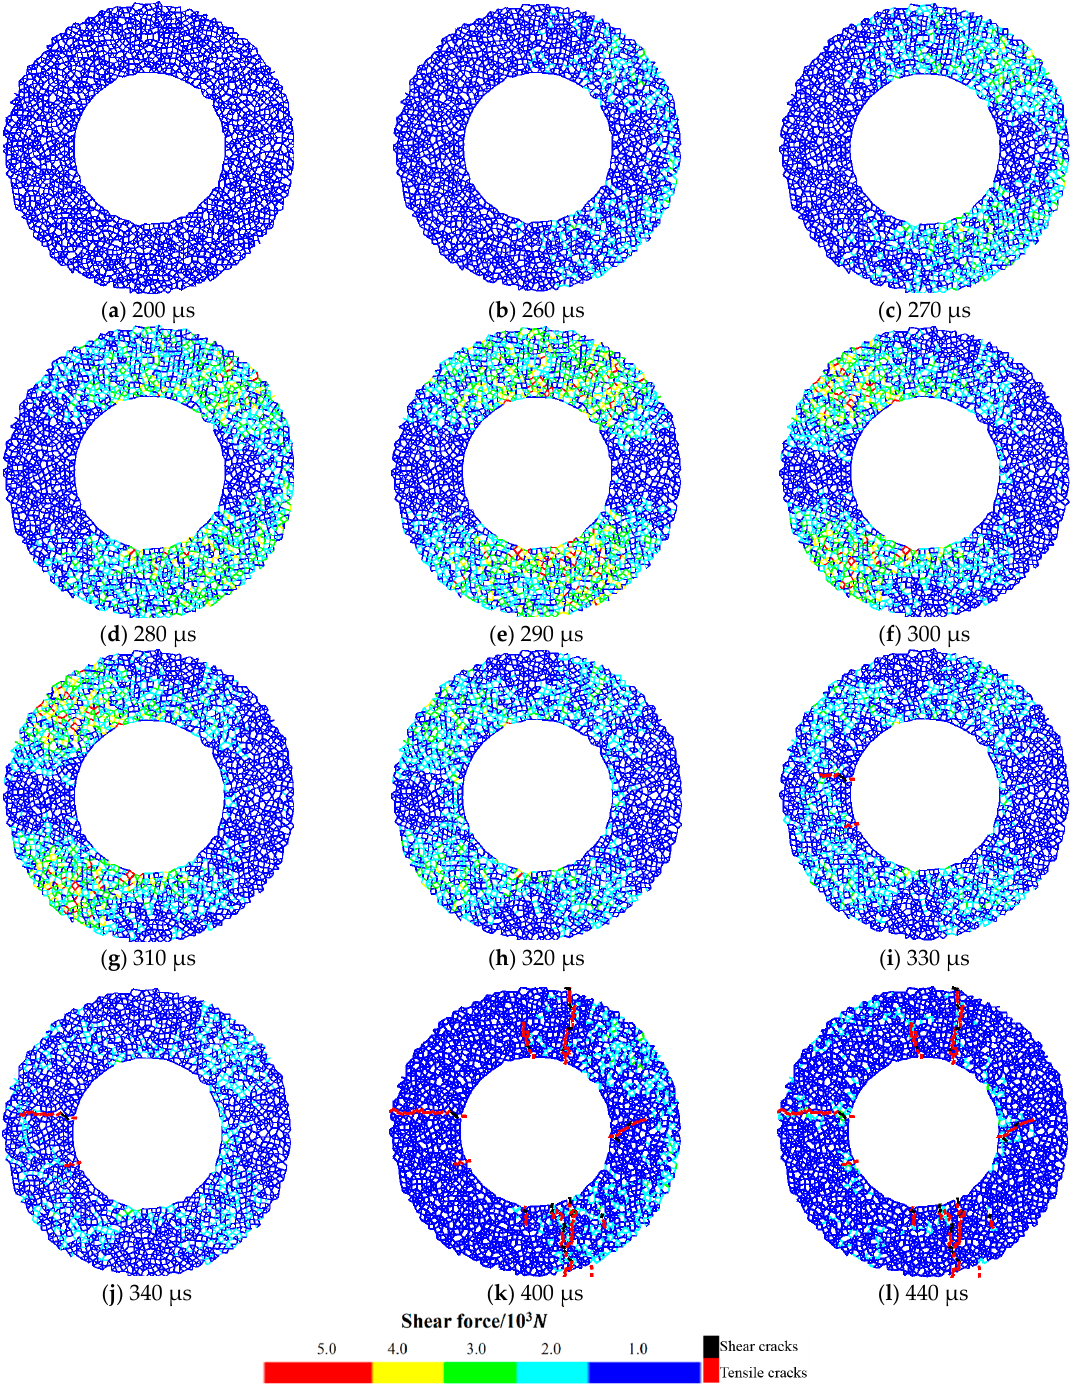
Figure 15. Evolution of shear force chain.